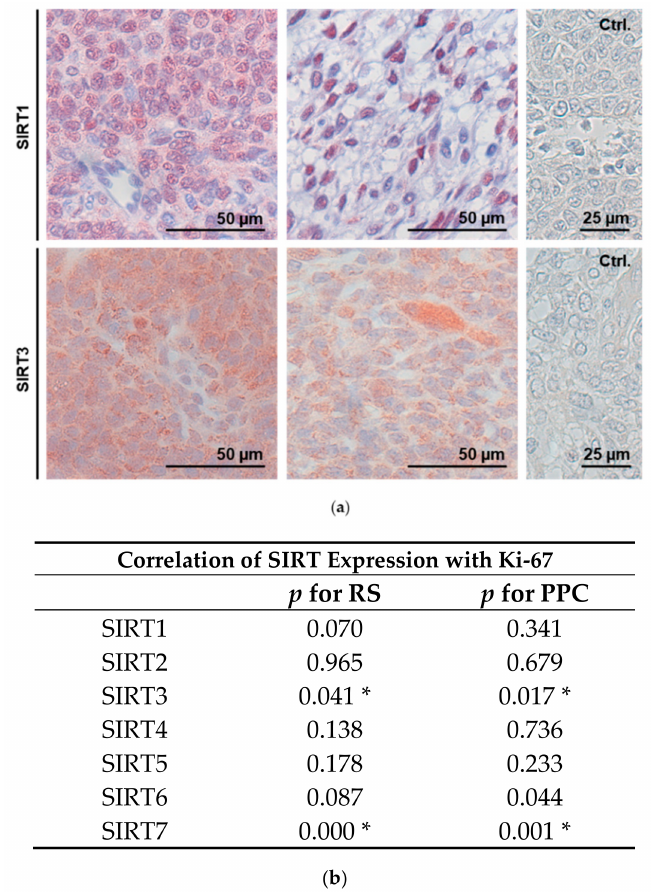
Figure 5. Immunohistochemical staining of SIRT1 and SIRT3 in GCTs ( a ). SIRT1 could be detected in the cytoplasm (left) and/or the nucleus (right), while SIRT3 staining pattern was punctured and found only in the cytoplasm (Ctrl., omission of first antibody). ( b ) Correlation of SIRT expression with proliferation (Ki-67) was calculated for both Remmele scores (RSs) and percentages of positive cells (PPCs). Results of the chi-square test are given, and * p < 0.05 was assumed to be significant. Note that for SIRT3 and SIRT7, a higher expression correlated with a higher Ki-67 expression (for evaluation of RS and PPC for calculating the correlation of SIRT1–7 expression with proliferation (Ki-67), see Supplementary Table